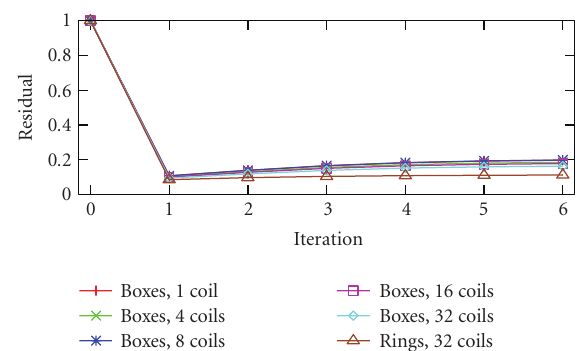
Figure 8: L 2 di ff erence between true image and reconstruction after conjugate gradient